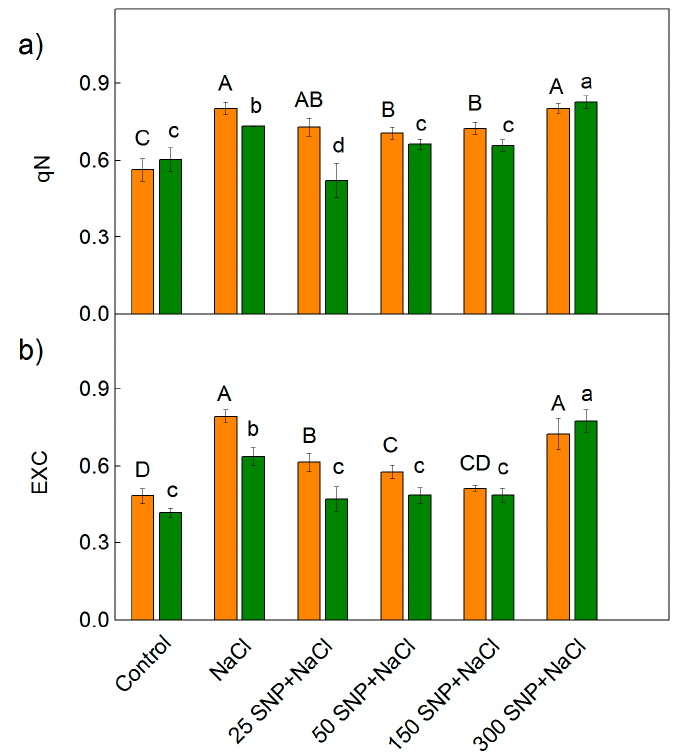
Figure 6. Effects of SNP on ( a ) the non-photochemical quenching of the chlorophyll fluorescence (qN) and ( b ) the excess excitation energy (EXC) in the leaves of the two sorghum varieties (Albanus—orange bars and Shamal—green bars) under salt stress. Mean values ( ± SE) were calculated from eight independent measurements. The significant differences among treatments at p < 0.05 are indicated by different letters (uppercase for Albanus and lowercase for Shamal).